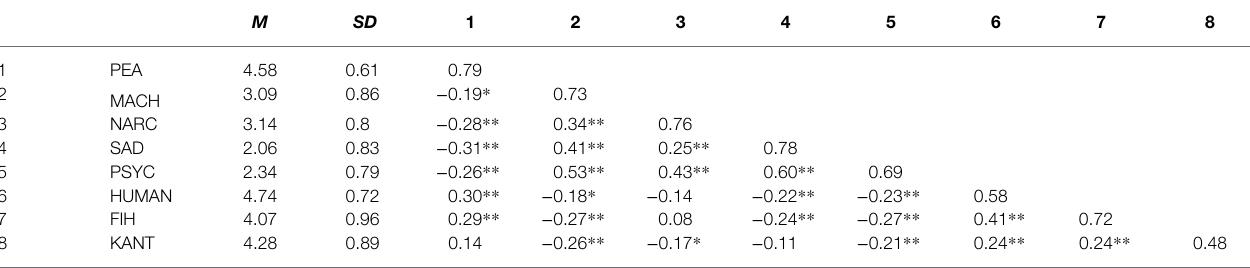
TABLE 3 | Spearman’s rank rho correlations matrix as well as reliabilities (Cronbach’s alpha; diagonal) of Study 2 ( N =